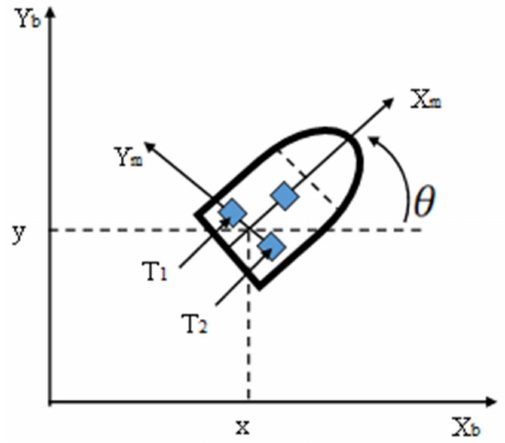
Figure 5. Diagram of the mobile robot system. The interval type-3 trapezoidal MF, (cid:101) µ A ( x , u ) = ScaleTrapScaleGaussT3MF with trian- gular FOU ( A ) , is characterized with parameters [ a 1 , b 1 , c 1 , d 1 ] (UpperParameter) for UMF and parameters λ (LowerScale), (cid:96) (LowerLag) for LMF to form the DOU = [ µ ( x ) , µ ( x )